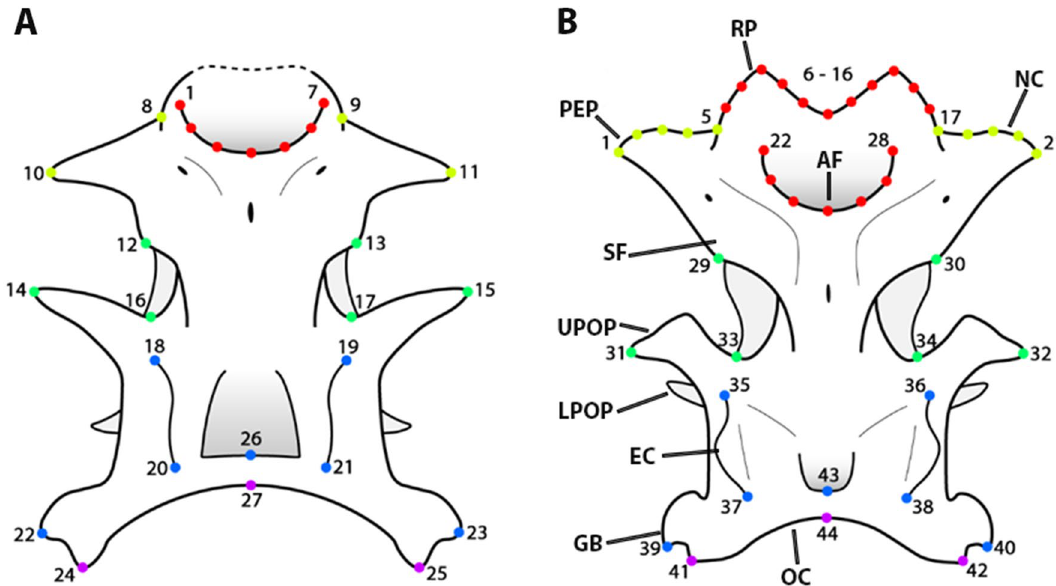
Figure 7. Dorsal view drawings of the neurocranium morphology of † Pseudorhina and Squatina . Landmark configuration on the neurocranium for the data set including † Pseudorhina acanthoderma ( A ).